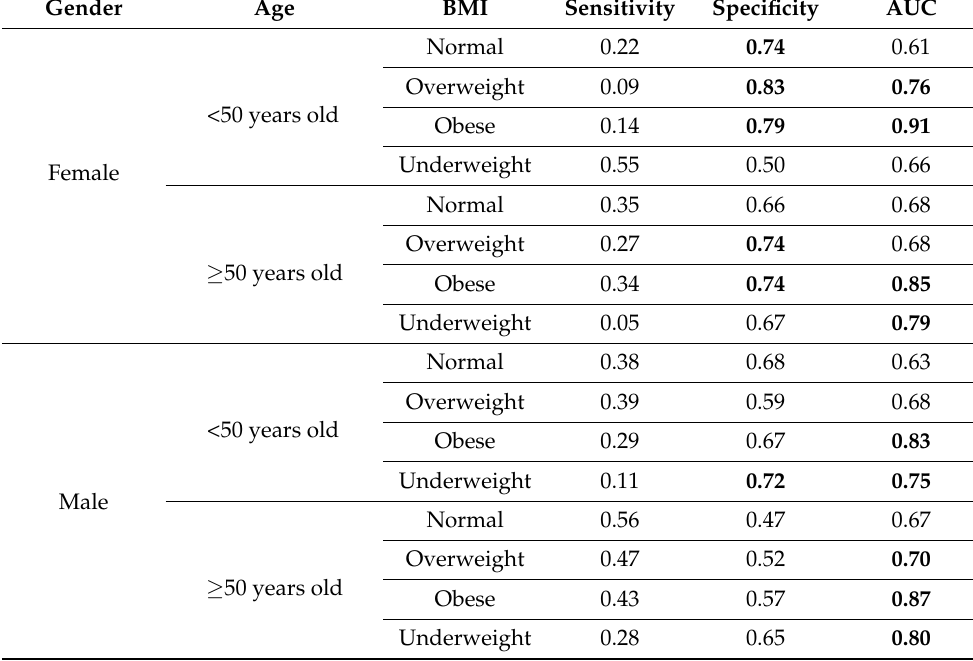
Table 3. Noninvasive stratifying tool (random forests